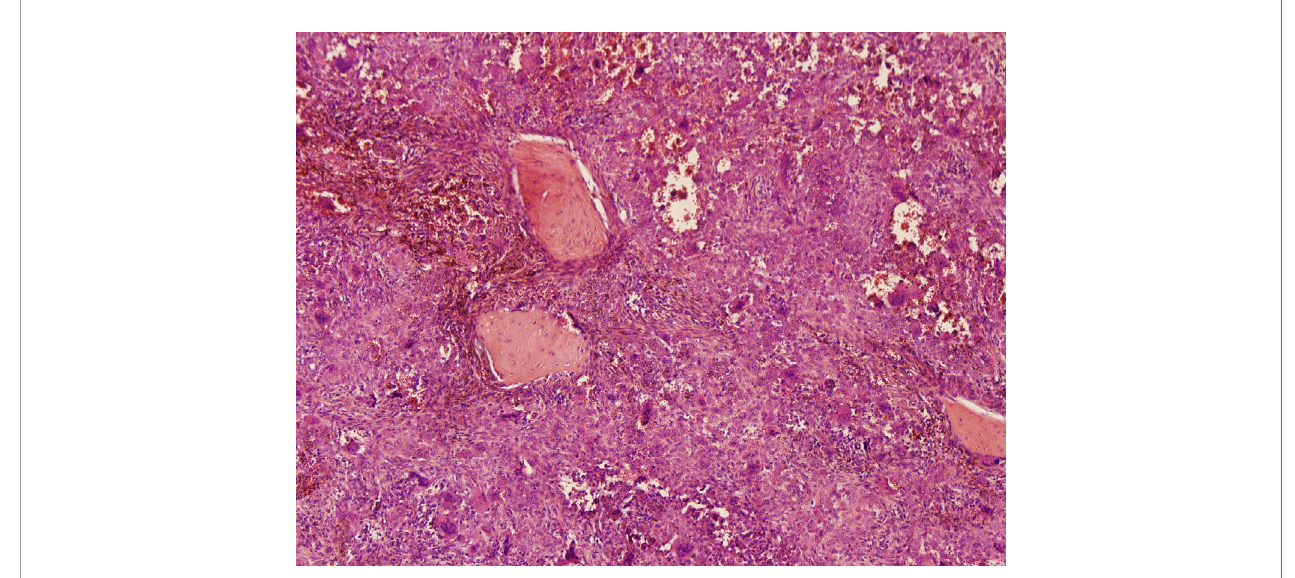
FIGURE 3 | Histology of a diffuse tenosynovial giant cell tumor (D-TSGCT) of the temporomandibular joint (TMJ). Microscopic examination reveals large amount of mononuclear cells, irregularly distributed osteoclast-like giant cells, and hemosiderin pigments (hematoxylin-eosin [HE], original magni fi cation ×